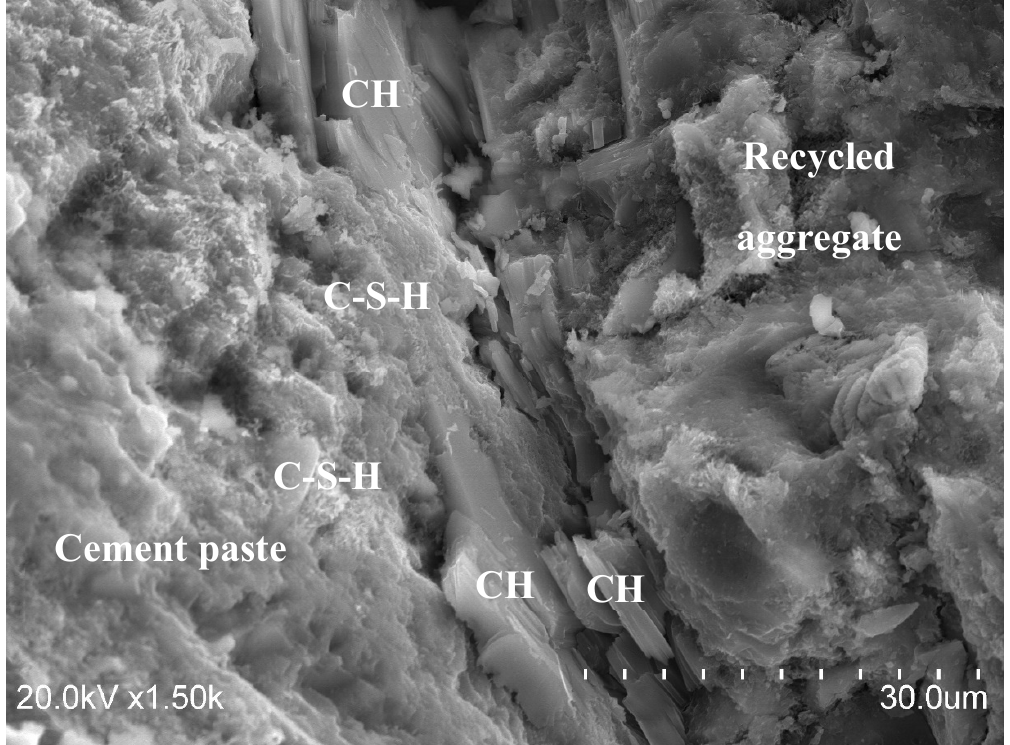
Figure 9. SEM image of recycled concrete, showing the cement hydration products.